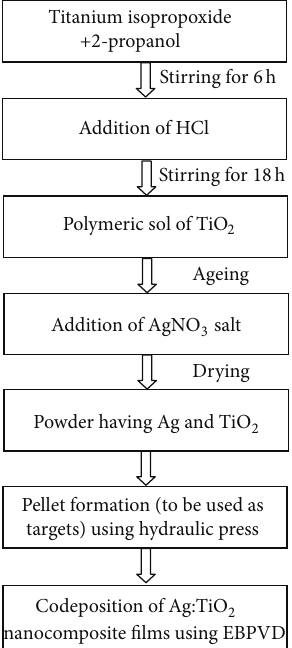
Figure1:FlowchartofvarioussynthesisstepsofAg:TiO 2 nanocom- posite thin